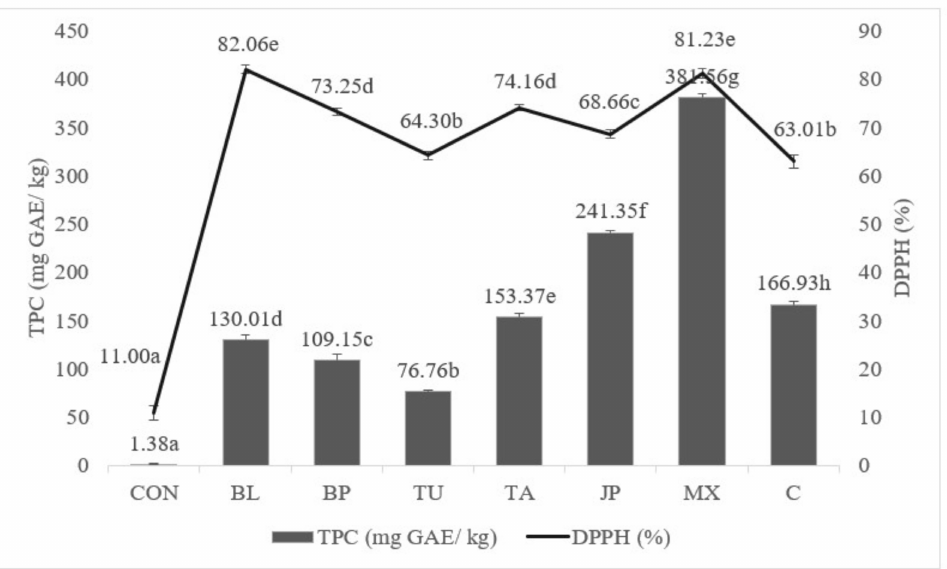
Figure 2. The effect of marinade on TPC and DPPH (mean ± standard deviation) of grilled pork. a–h—the mean values marked with various lowercase letters correspond to statistically significant differences ( p <